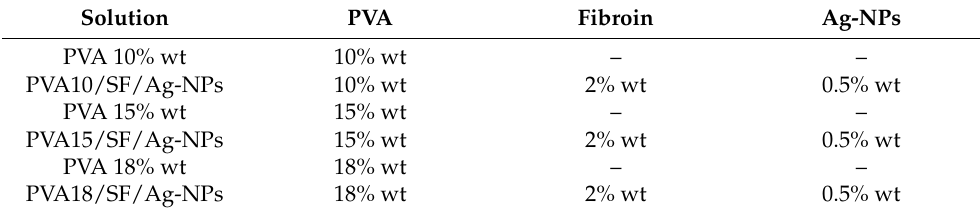
Table 1. Electrospinning